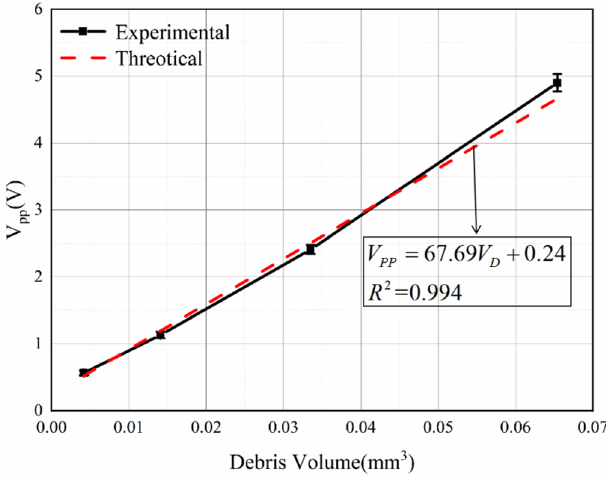
Figure 14. The V pp values of the induced voltage versus volume.